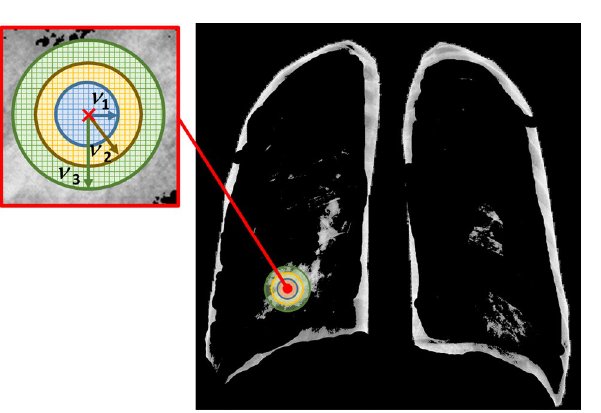
Figure 2. Illustration steps for the first two preprocessing steps in the proposed CAD system: ( a ) original X-ray image, ( b ) roughly segmented lung region, ( c ) enhanced contrast of lung region, and ( d ) extracted candidate of abnormal tissues.